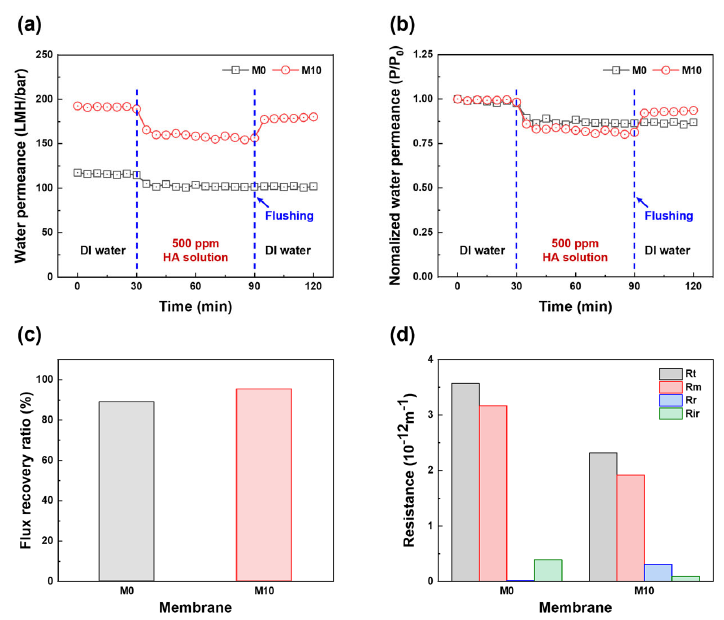
Figure 7. Antifouling properties of PES and FCNT/PES nanocomposite HF membranes. ( a ) Water permeance as a function of time. ( b ) Normalized water permeance as a function of time (P/P 0 : water permeance relative to the initial water permeance). ( c ) Flux recovery ratio. ( d ) Resistance profiles.